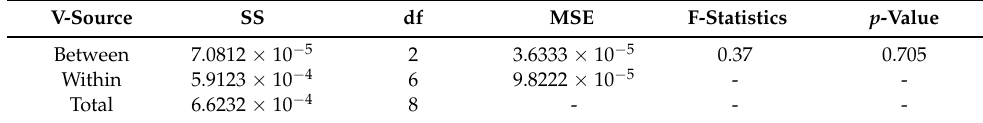
Table 5. Statistical test results based on ANOVA using accuracy metric.